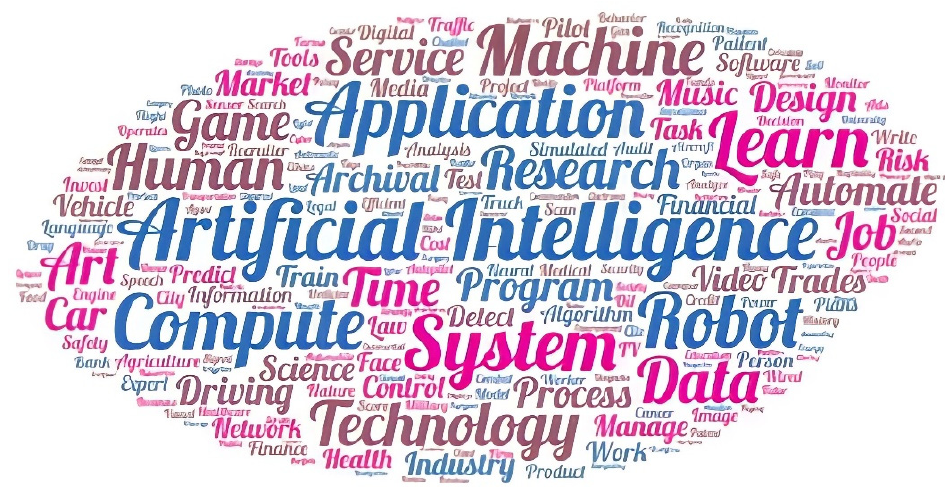
Figure 1. Word cloud generated from the applications of AI.